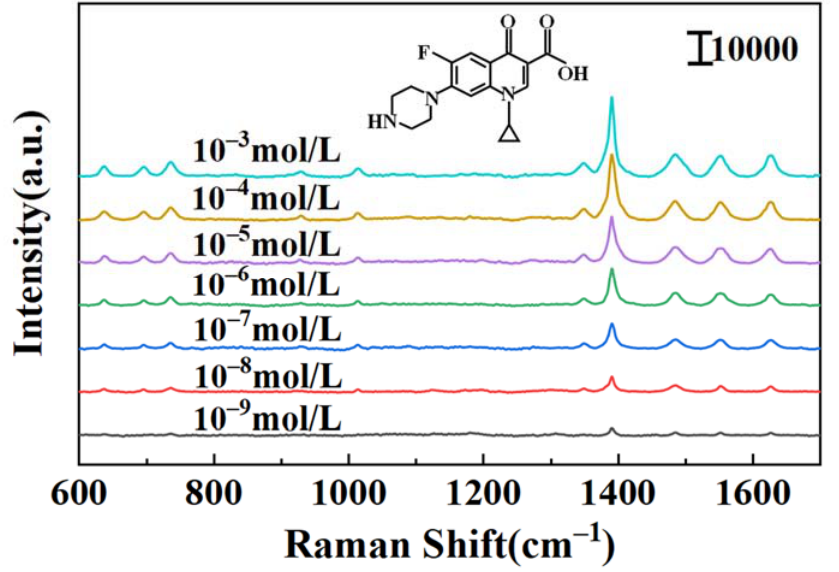
Figure 7. SERS spectra of dendritic Au–Ag nanoparticles adsorbed to different concentrations of ciprofloxacin.